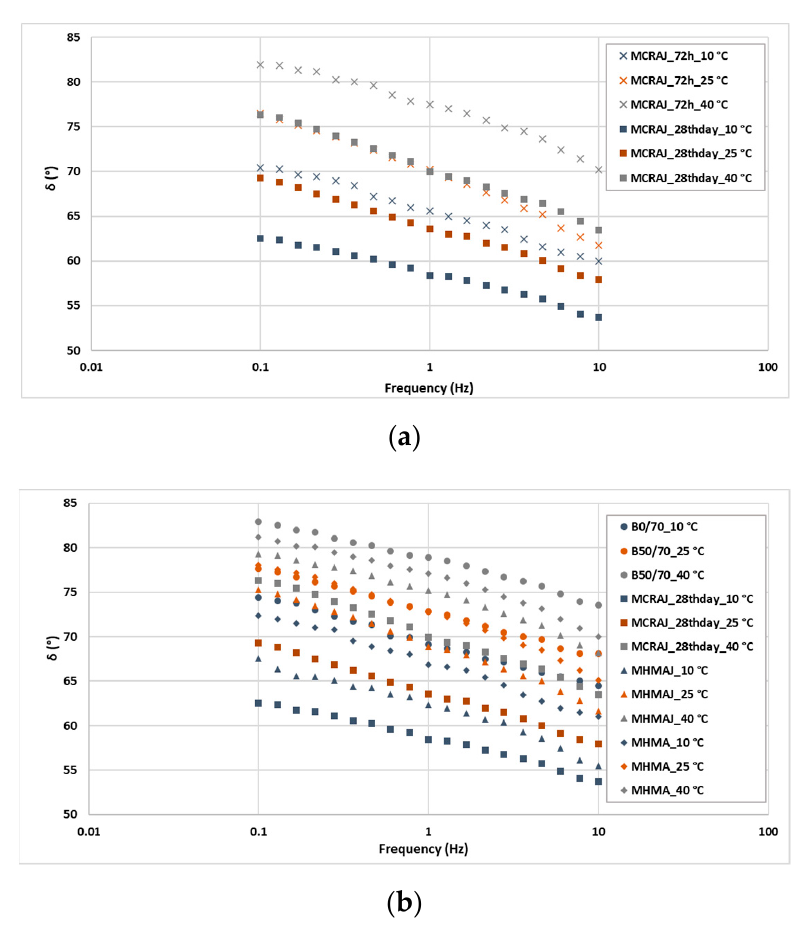
Figure 15. Isothermal plot of phase angle for comparison between ( a ) CMRAJ by curing time and ( b ) neat bitumen vs. asphalt mastics.